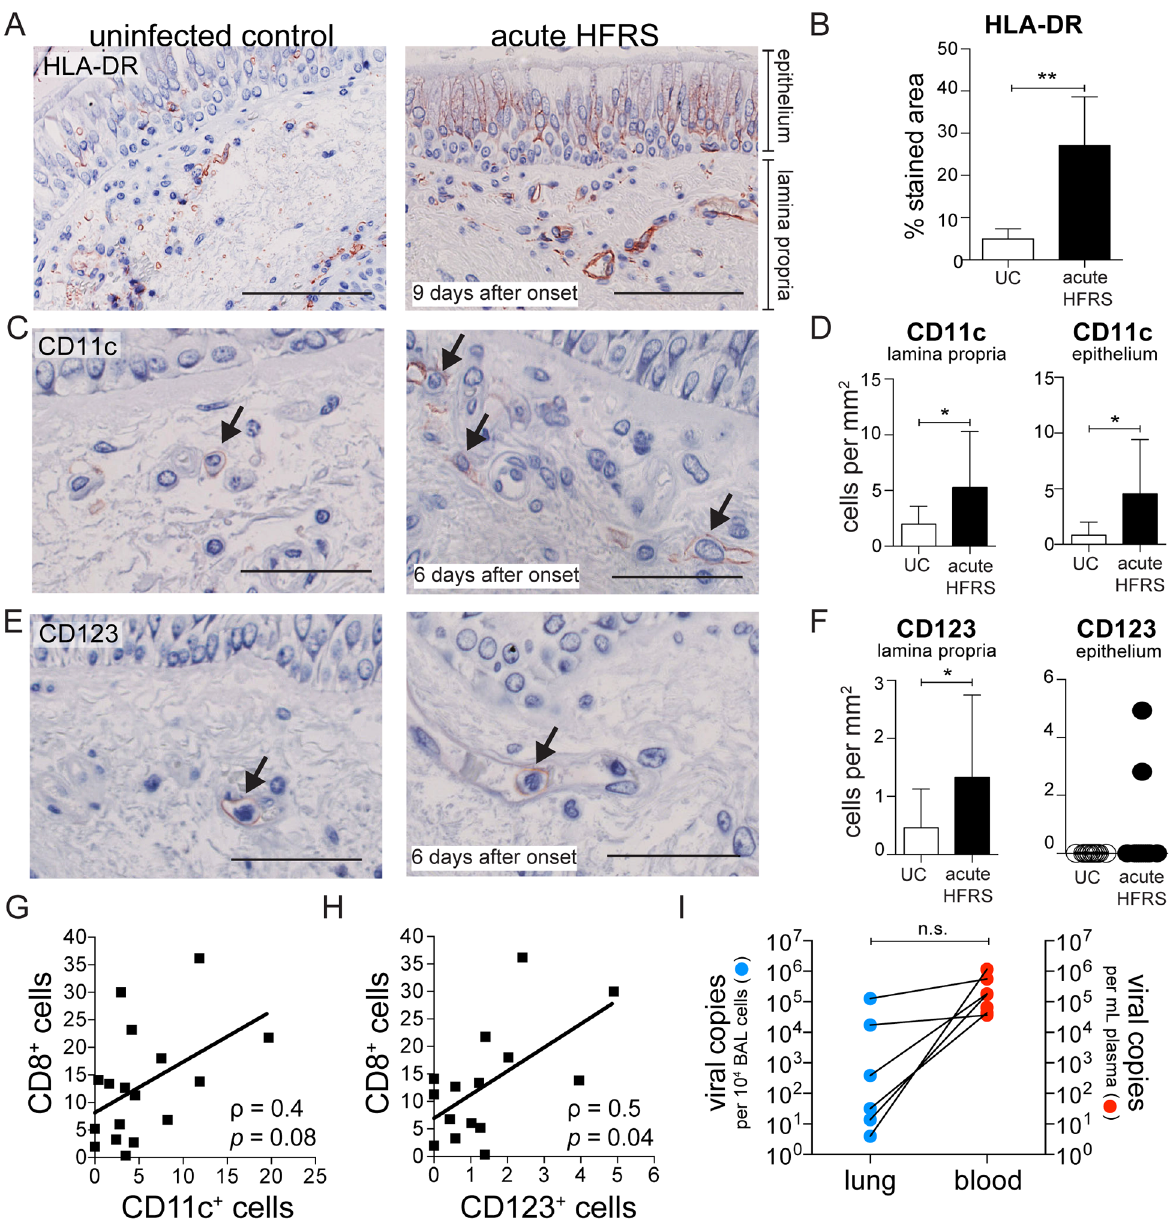
Fig 2. Infiltration of MNPs into the airways during acute hantavirus infection. Endobronchial biopsieswere taken from patients with acute HFRS and age- and sex-matched UC. ( A ) Representative images of endobronchial biopsiesrevealinghigh numbers of HLA-DR + cells in HFRS patients (n = 5), as comparedto UC (n = 5) are shown. Specific staining appearsin red, and cell nuclei are counterstained with hematoxylinin blue. Arrows indicate positive staining.Visualization was performed using immunohistochemistry. Scale bar, 100 μ m. ( B ) Bar graph summarizesmean ± SDpercentage of HLA-DRstained areas of all subjects. Representative images of ( C ) CD11c and ( E ) CD123 stainingin lamina propriaand epitheliumin endobronchial biopsiesfrom HFRS patients and UC. Scale bar, 50 μ m. ( D and F ) Bar graphs summarize mean ± SDcomparing HFRS patients (n = 17) duringthe acute phaseof infectionwith UC (n = 16). The numbers of CD11c + or CD123 + cells are expressedas cells/mm 2 of epitheliumand lamina propria, respectively.Statistical differences were assessedusing two-tailedMann–Whitney U-test: * p < 0.05 ** p < 0.01.Graphs show the positive correlation( ρ ) of CD8 + cells to ( G ) CD11c + cells and ( H ) CD123 + cells in endobronchial biopsiesof HFRS patients as assessedby Spearman’s correlationtest (n = 17). ( I ) Detectableviral load in BAL cells (per 10 4 cells) and plasma (per mL) of HFRS patients measured by viral RNA quantification on the day of bronchoscopy. Lines indicatepairedmeasurements in BAL cells and plasma of individual patients (n = 8).